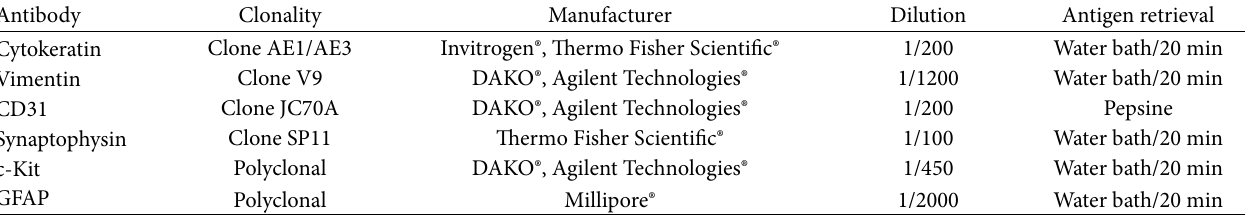
Table 1: List of antibodies investigated, dilutions and antigen retrieval methods applied in the immunohistochemical analysis.